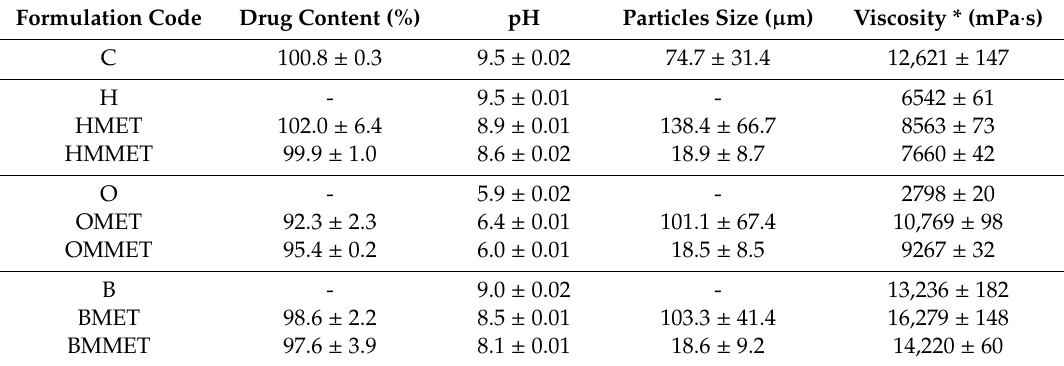
Table 3. Drug content, pH, particles size and viscosity of prepared hydrogels, oleogels and bigels containing MET (HMET, OMET, BMET) or MMET (HMMET, OMMET, BMMET), placebo gels (H, O, B) and commercially available product